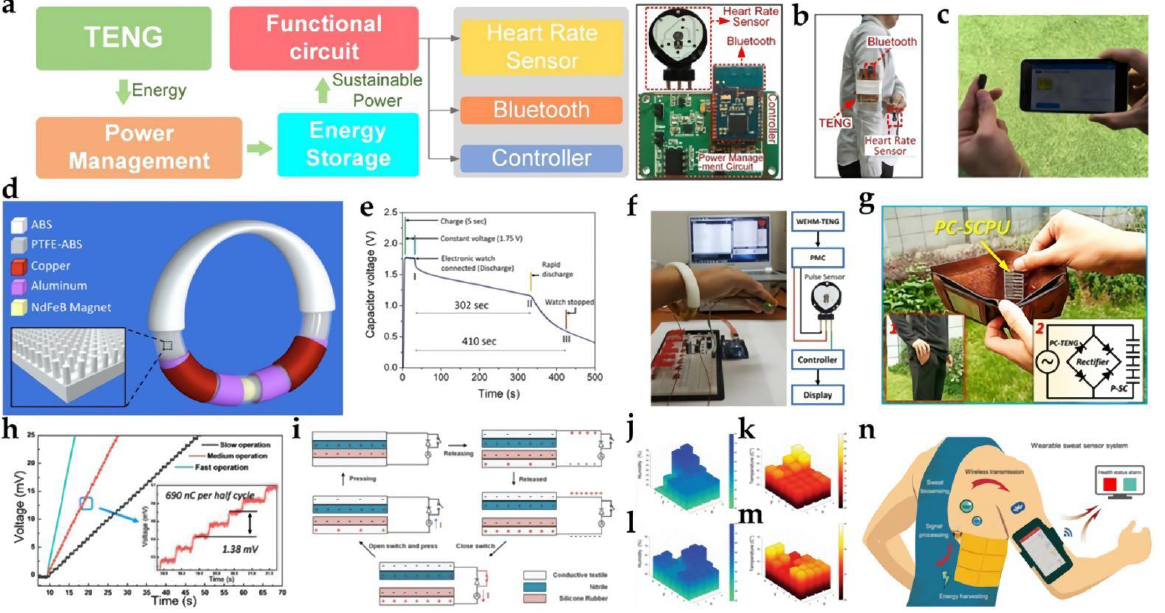
Figure 7. TENGs as power sources to drive biosensing devices. ( a ) System diagram of the complete power-supplying system. ( b ) Photograph showing that the integrated system was equipped onto a human arm. ( c ) Photograph showing that the acquired heart-rate data were wirelessly transmitted to a cell phone in real-time. Reprinted/adapted with permission from Ref. [73]. 2017, Lin et al. Amer- ican Chemical of Society. ( d ) Schematic diagram of the fabricated hybrid nanogenerator. Inset: sketch of the nanostructured polytetrafluoroethylene film at an angle of 30°. ( e ) Voltage charging and discharging curves for a 1000 µF capacitor during driving a wrist-watch, showing starting phase I, rapid discharging phase II, and watch stop phase III. ( f ) Demonstration of heart-rate and pulse-signal monitoring powered by the hybrid nanogenerator; inset showing a diagram of a heart- rate-monitoring system. Reprinted/adapted with permission from Ref. [125]. 2018, Maharjan et al. Elsevier. ( g ) Photograph of the practical application of a PC-SCPU placed in a wallet. Inset 1 shows that an ultralight PC-SCPU can be easily placed in the pocket. Inset 2 shows the electric circuit loop of the PC-SCPU. ( h ) V – t curve of the PC-SCPU with charging by hand flapping (from slow operation to fast operation). Reprinted/adapted with permission from Ref. [126]. 2017, Guo et al. American Chemical of Society. ( i ) Working mechanism of the D − T − TENG. ( j , k ) Humidity and temperature distribution of the lab environment with 20 sampling points. ( l , m ) Humidity and temperature dis- tribution of the apartment with 24 sampling points. Reprinted/adapted with permission from Ref.[127]. 2019, He et al. Wiley Online Library. ( n ) Schematic illustrating the FWS 3 that integrates human motion energy harvesting, signal processing, microfluidic-based sweat biosensing, and Bluetooth-based wireless data transmission to a mobile user interface for real-time health-status tracking. Reprinted/adapted with permission from Ref. [128]. 2020, Song, Science. Song et al. designed a TENG − powered wearable sweat sensor system compatible with traditional flexible printed circuit board (FPCB)-manufacturing processes that can dynamically monitor key sweat biomarkers (e.g., pH and Na + ) (Figure 7n) [128]. The TENG consisted of an interdigital stator and a grating-patterned slider. PTFE and copper were used as tribo-pairs. With an electroless nickel/immersion gold (ENIG) surface finish on the electrode area, the stator was further laminated by PTFE. Then, the sweat sensor patch was designed based on ion-selective electrodes. For pH analysis, the deprotonation of H + atoms on the surface of the electrodeposited PANI layer was an indicator of the bulk H + concentration. Na + concentration measurements were facilitated by a thin ion-selective membrane containing a Na + ionophore X, and a poly-(3,4-ethylenedioxythiophene (PE- DOT):poly-(sodium 4-styrenesulfonate) (PSS) layer in between the gold electrode layer